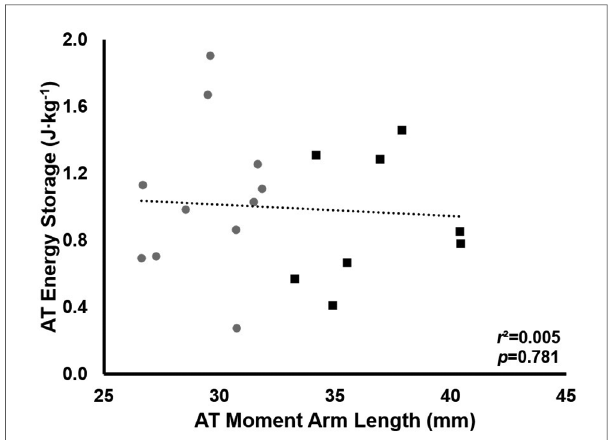
FIGURE 7 EMG amplitude for lateral gastrocnemius (LG) and soleus (SOL) during the stance phase of running. Values are presented as mean±SD. Black bars represent the long AT MA group while the grey bars represent the short AT MA group.